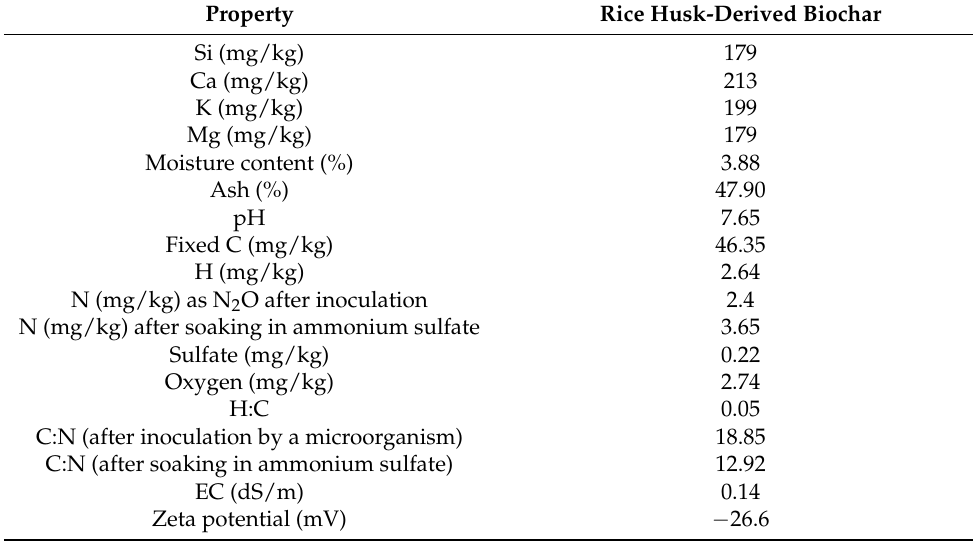
Table 3. Chemical compositions of prepared rice husk-derived biochar.